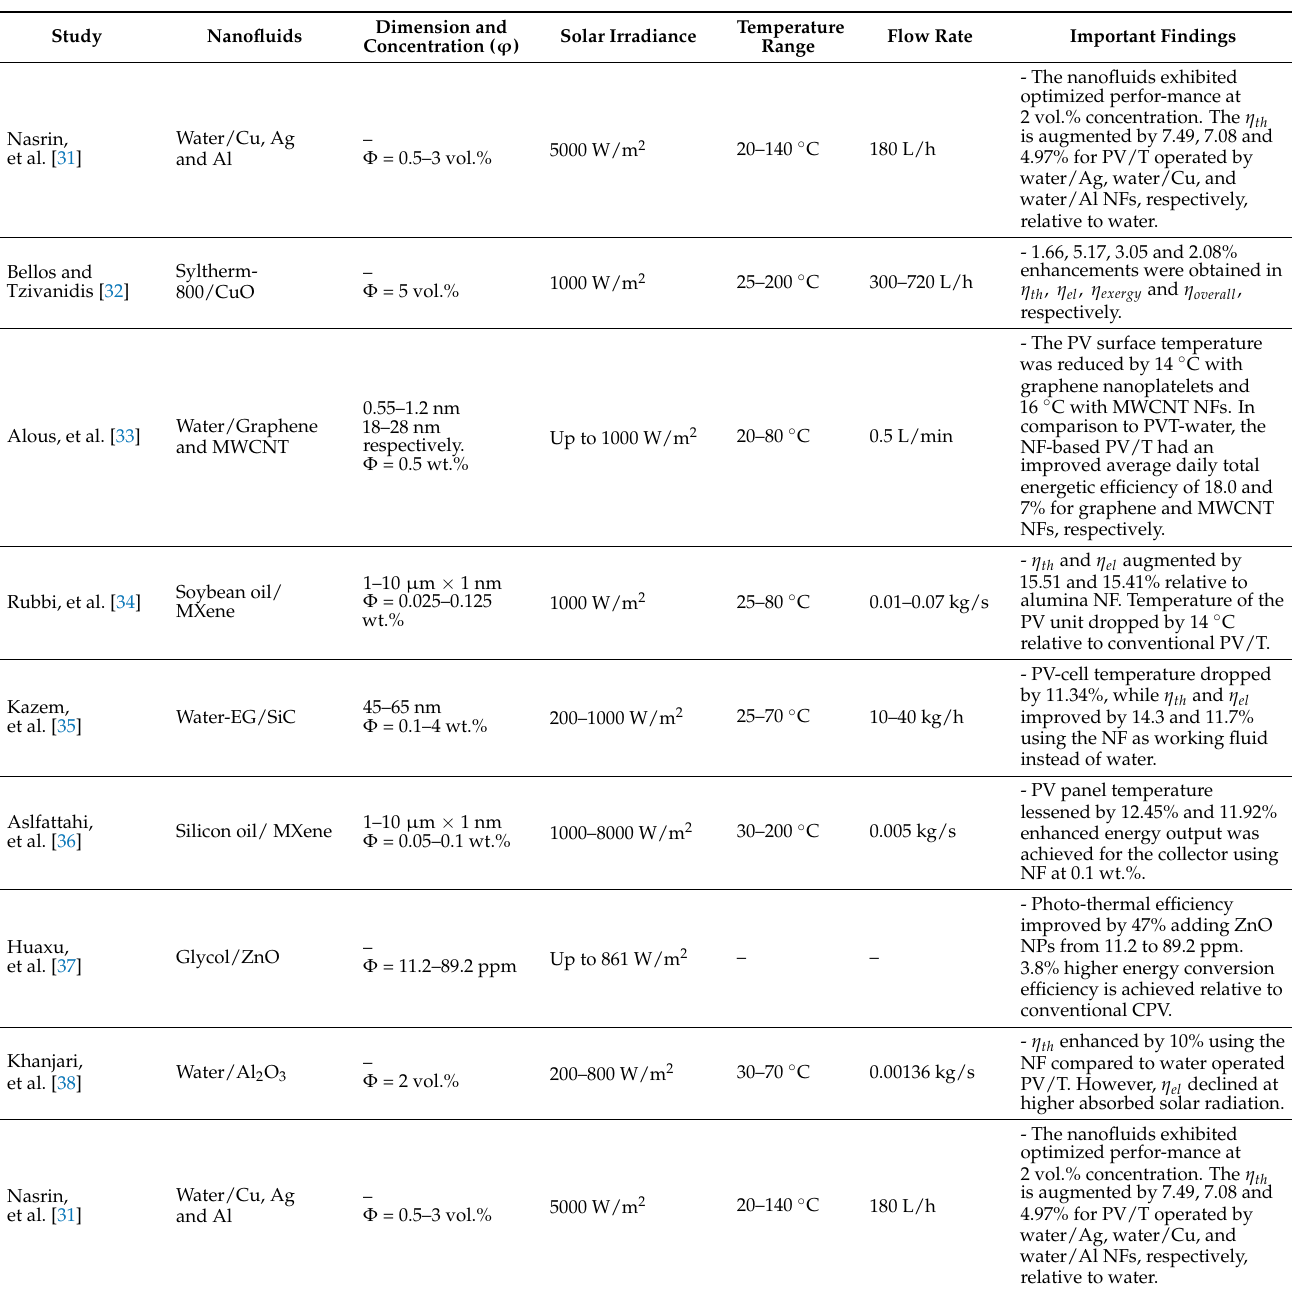
Table 1. Summary of recent studies on PV/T or CPV/T system using different nanofluids at various operating